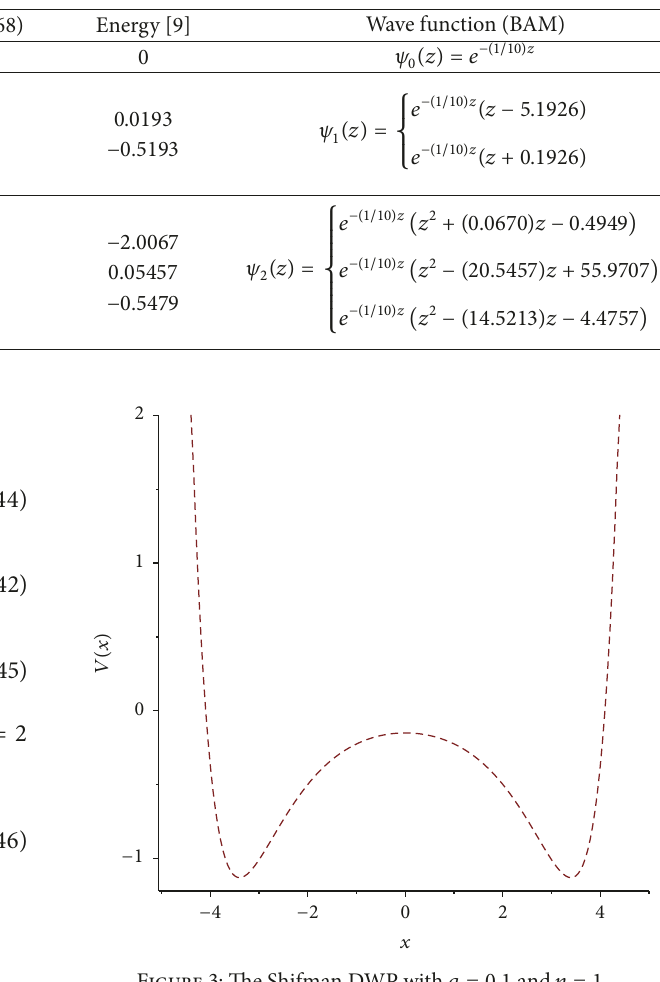
Figure 3: The Shifman DWP with 𝑎 = 0.1 and 𝑛 = 1